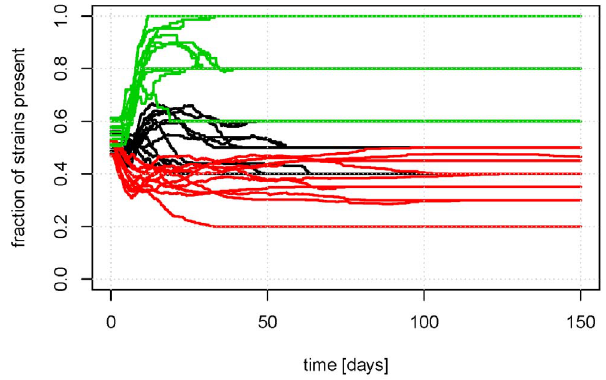
Figure 5. The variation of the repeats from figure 4. The mean fraction of strains that is present in a pig ( P I ( S i , j w 0 : 01 : C ) / n S n p n pp ) as a function of time with no antimicrobial treatment is shown for ten repetitions. The colors indicate the number of strains in the model: green =5 strains, black =10 strains, and red =20 strains. The leveling out after some time indicates that some strains have been completely eradicated from the pen population. ( n pp ~ 15 , n p ~ 1 , j ~ 10 { 3 , Q ~ 0 : 1 ).